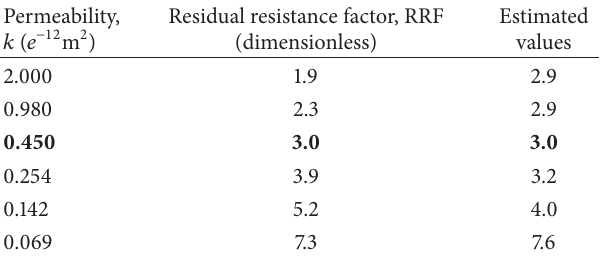
Table 2: Observation and estimation of RRF at various permeabili- ties.